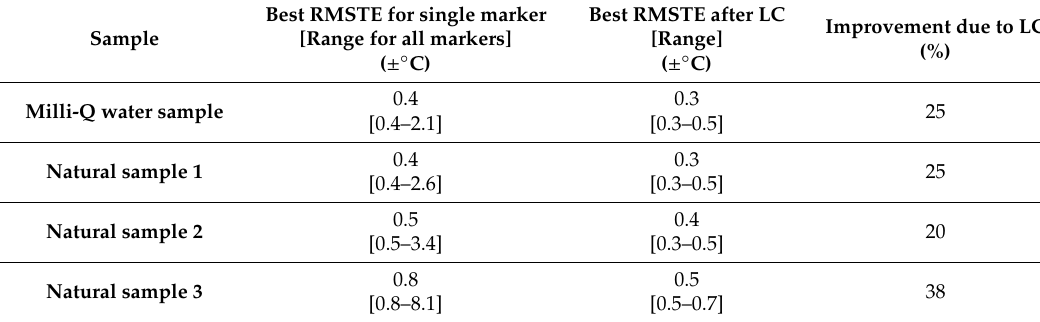
Table 4. RMSTE improvement after linear combination (LC)